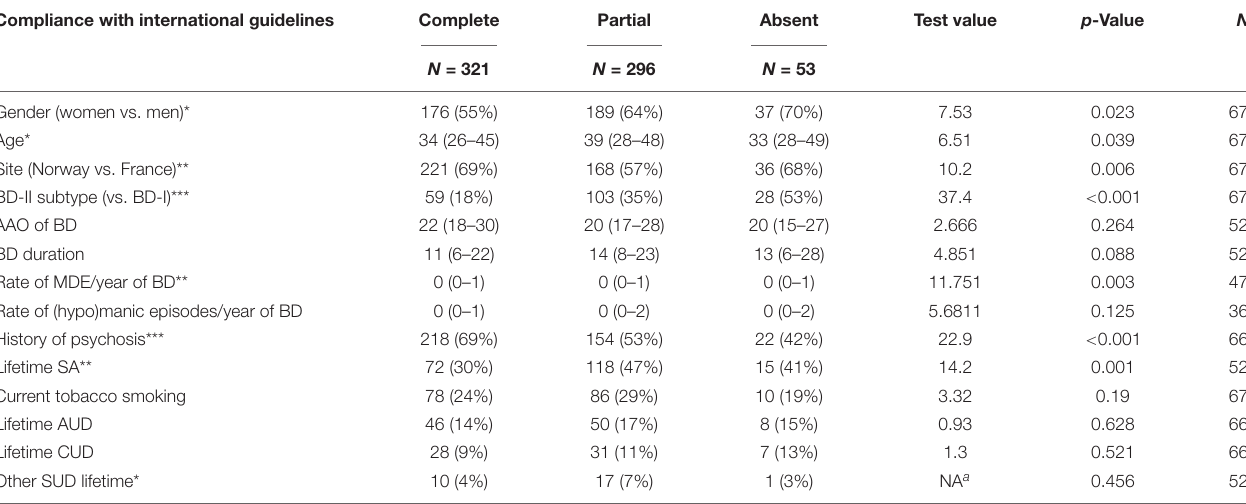
TABLE 2 | Variables associated with compliance to treatment guidelines in the whole medicated sample ( N =